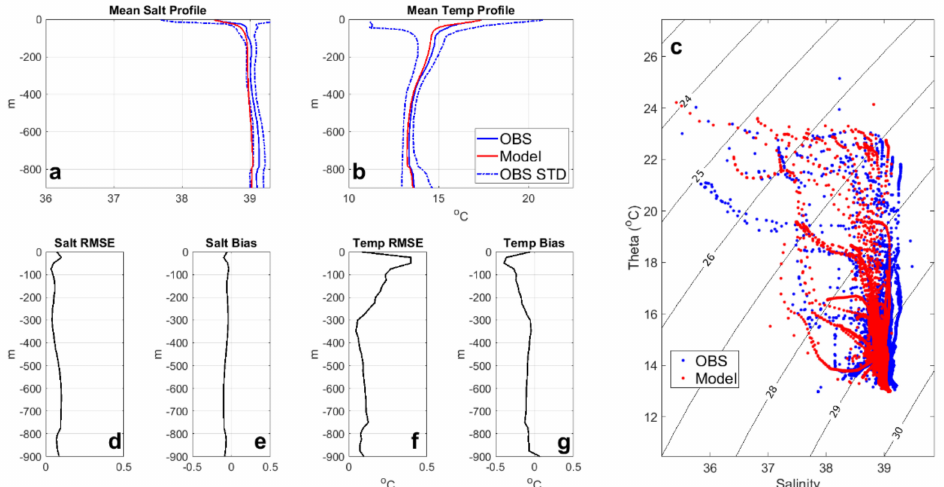
Figure 13. Hydrographic properties of Skyros basin. Panels ( a , b ) are the mean salinity and tem- perature profile from the surface to 900 m depth, respectively. Model output is given with a red solid line, observations with a blue solid line and the standard deviation with a dashed blue line. Panels ( d – g ) is the mean profile error—RMSE and Bias—estimation for the tracer. Finally, at panel ( c ) is the θ /S diagram for all observations (blue dots) and the corresponding model data (red